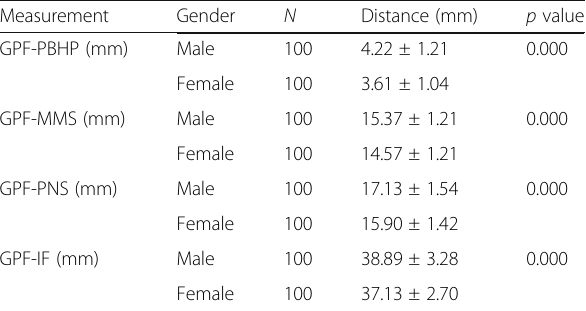
Table 10 Measurements taken from the GPF based on gender Measurement